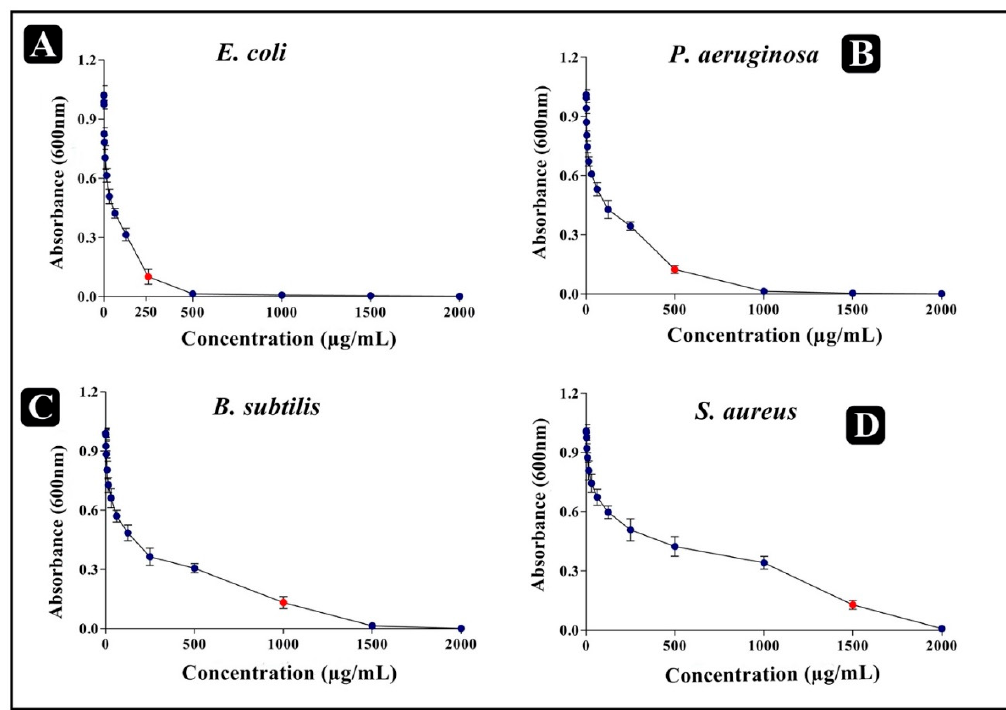
Figure 2. Determination of MIC after taking optical density at 600 nm ( A ) E. coli , ( B ) P. aeruginosa , ( C ) B. subtilis , and ( D ) S. aureus. All experiments were carried out in triplicate, and data represent the mean ± SEM. Biomolecules 2020 , 10 , x Table 1. Antibacterial activity of P. sophore mucus extract.